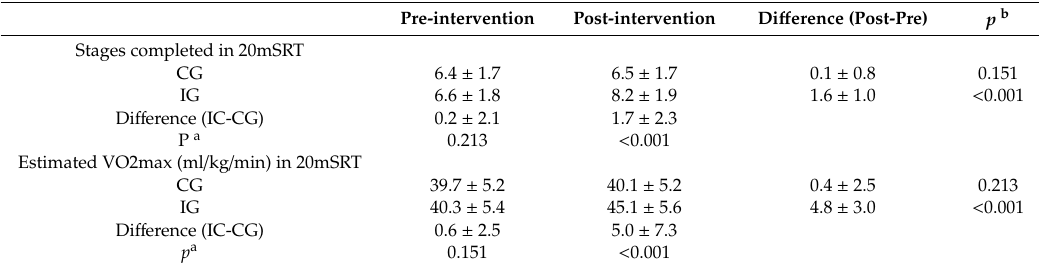
Table 4. Changes in cardiorespiratory fitness for control group and intervention